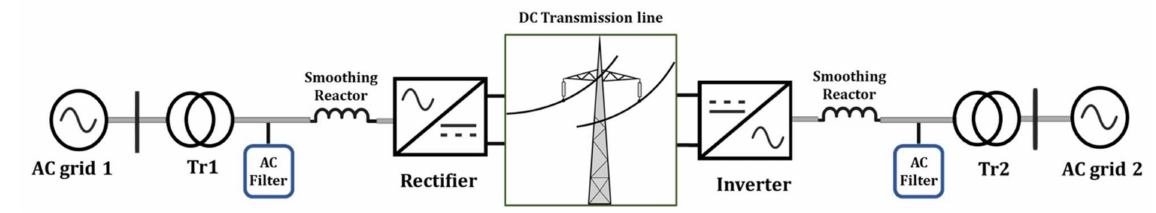
Figure 2. Configuration of HVDC transmission